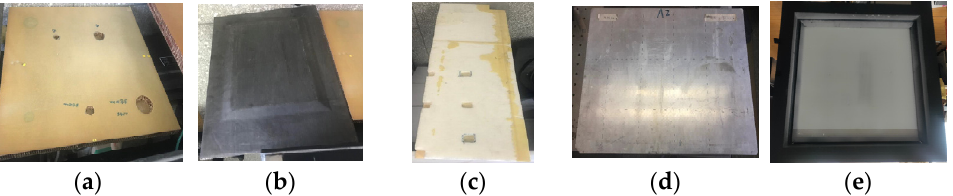
Figure 9. Experimental specimens: ( a ) specimen 1; ( b ) specimen 2; ( c ) specimen 3; ( d ) specimen 4; ( e ) specimen 5.